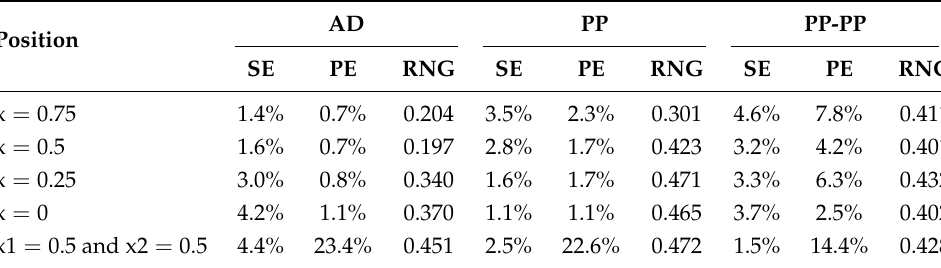
Table 1. Performance parameters from simulated